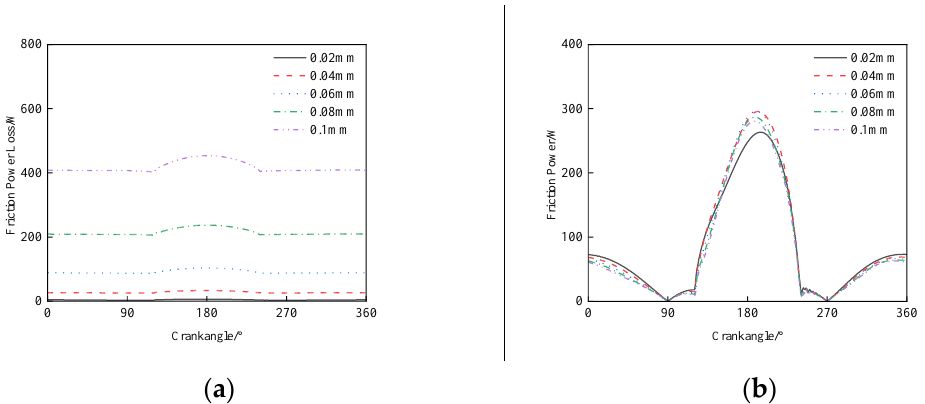
Figure 13. ( a ) Hydrodynamics lubrication friction power at different clearances. ( b ) Asperity contact friction power at different clearances.